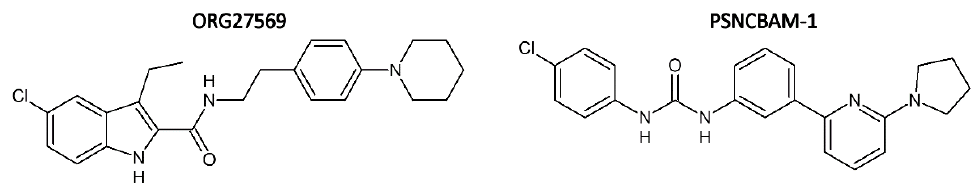
Figure 2. Chemical structures of CB 1 R allosteric ligands ORG27569 and PSNCBAM-1.